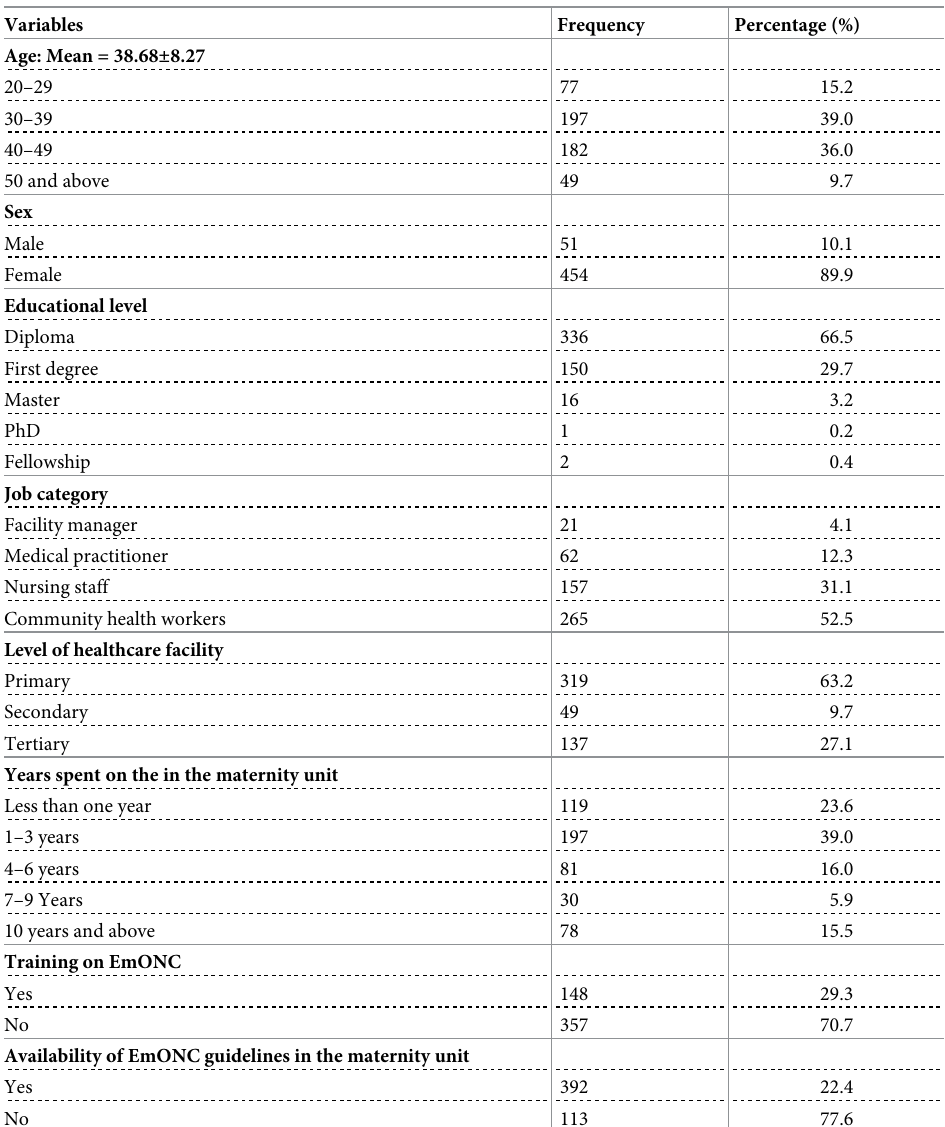
Table 1. Respondents’ socio-demographic and occupational characteristics (n =